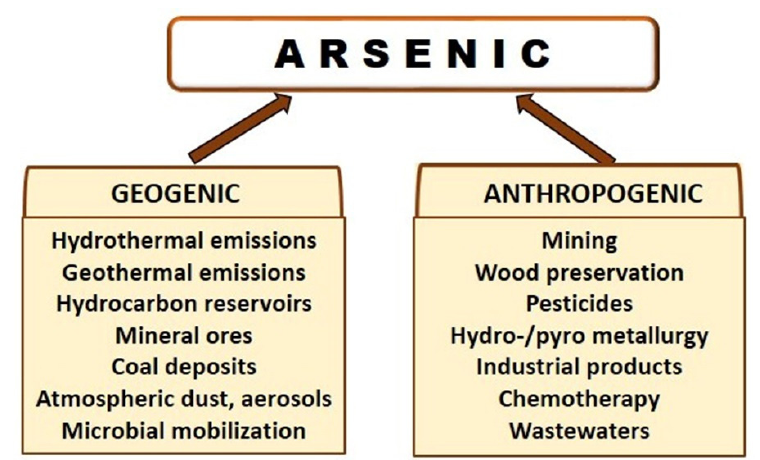
Figure 2. Sources of arsenicals in the biosphere.